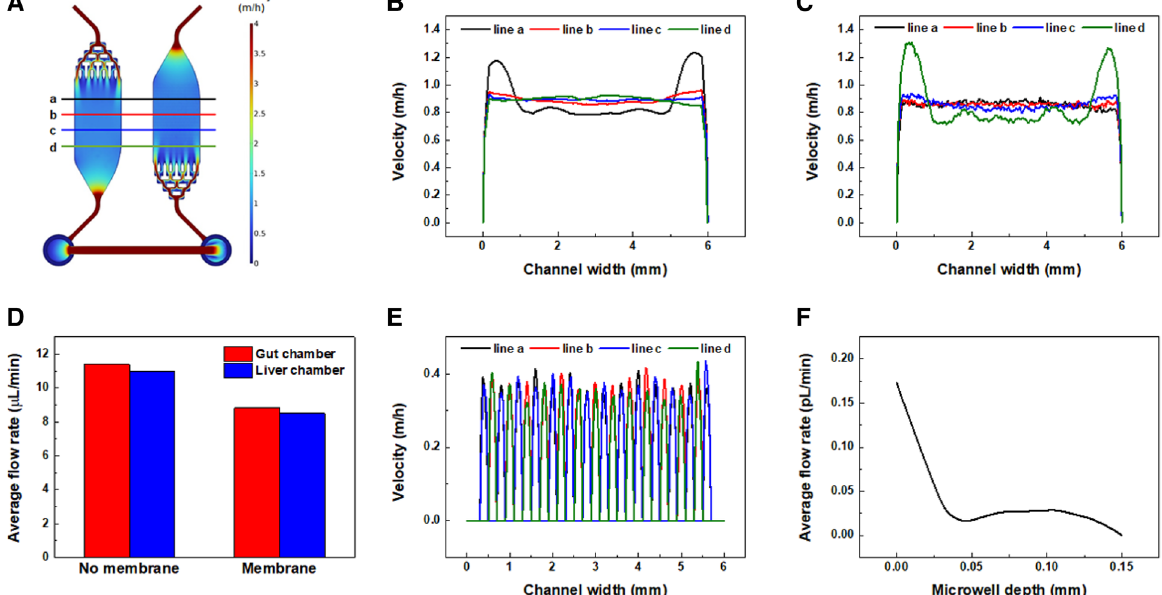
Fig. 2 Computational fluid dynamics simulation model for the analysis of flow distribution during osmotic pumping in a gut‑liver axis chip system. A Flow distribution in a gut‑liver axis chip. B The velocity profile in the gut chamber. Each dataset was extracted from the respective cutline a, b, c, and d as marked in A . C The velocity profile in the liver chamber. D Comparison graph showing the difference in average flow rate between membrane and no membrane. The insertion of membranes reduced the average flow rate by about 23%. E Velocity profile on the top of microwell arrays. F Average flow rate profile inside microwell arrays from the top to the bottom of the